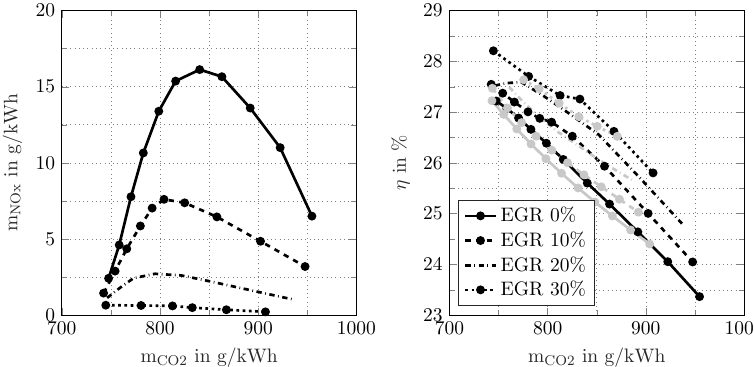
Figure 10. Measured effects of EGR on nitrogen oxide emissions m NOx and engine efficiency η (modeled values in grey) at p me = 3.19 bar for φ sweeps at various EGR